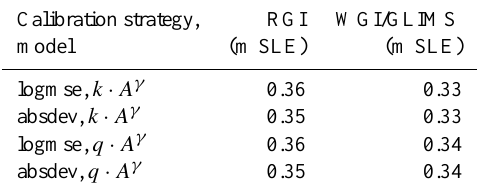
Table 5. Calculated total volume of two glacier inventories and three methods of calibrating the scaling law. The robust least ab- solute deviation estimate based on RGI is considered to be the best as there are serious inventory deficiencies with WGI/GLIMS (see text and Table